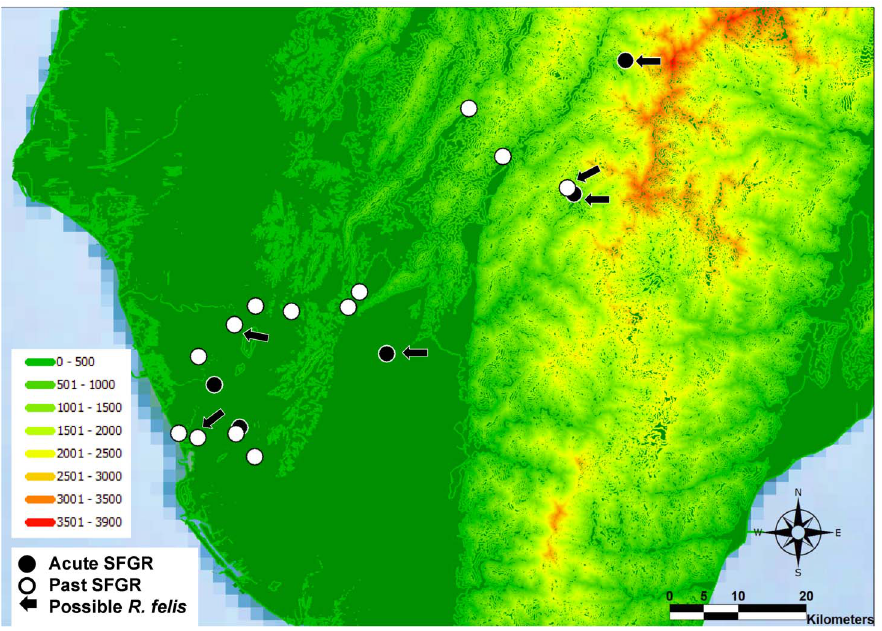
Figure 2. The case distribution of spotted fever group rickettsioses (SFGR) infections. Black circles: The 5 cases of acute infection SFGR. White circles: The 10 cases of past infection of SFGR. Black arrows: The 6 cases of possible Rickettsia felis infection.